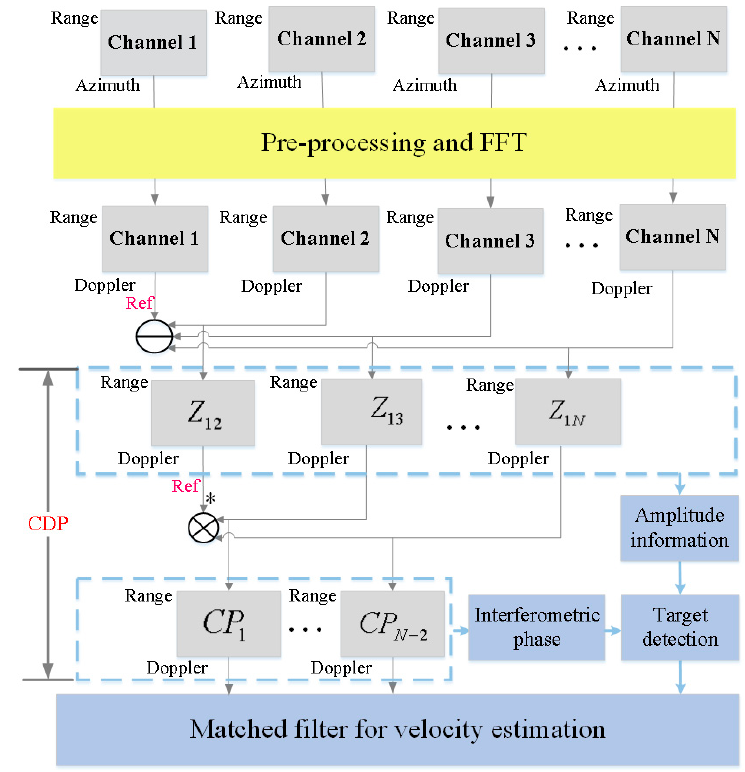
Figure 2. Framework of the proposed method.